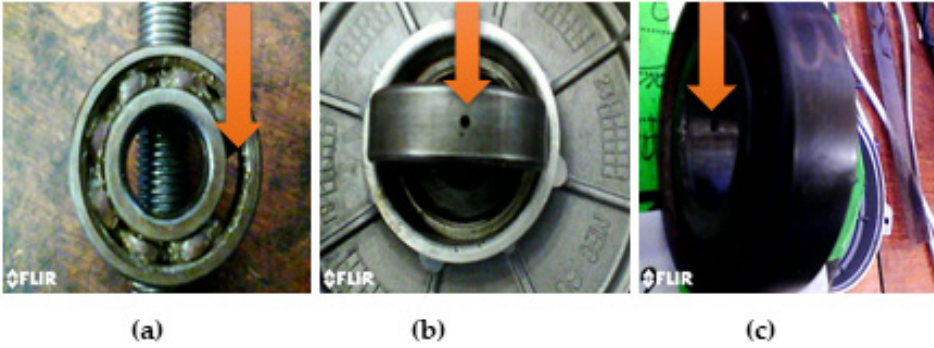
Figure 2. Block diagram of data sources.